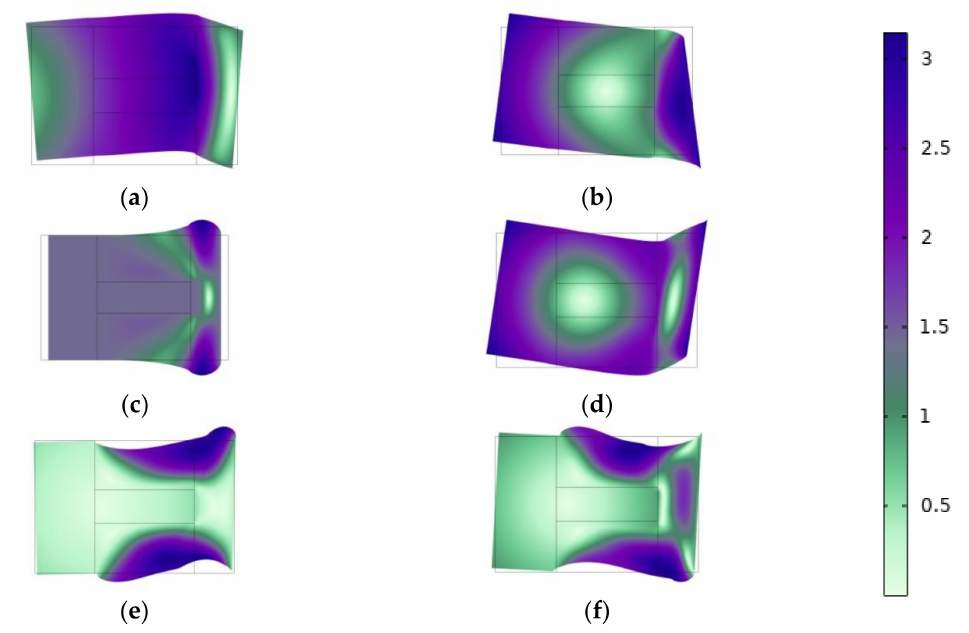
Figure 17. Band edge modes of points A 1 -A 5 and S, ( a ) Mode A 1 , ( b ) Mode A 2 , ( c ) Mode S, ( d ) Mode A 3 , ( e ) Mode A 4 , ( f ) Mode A 5